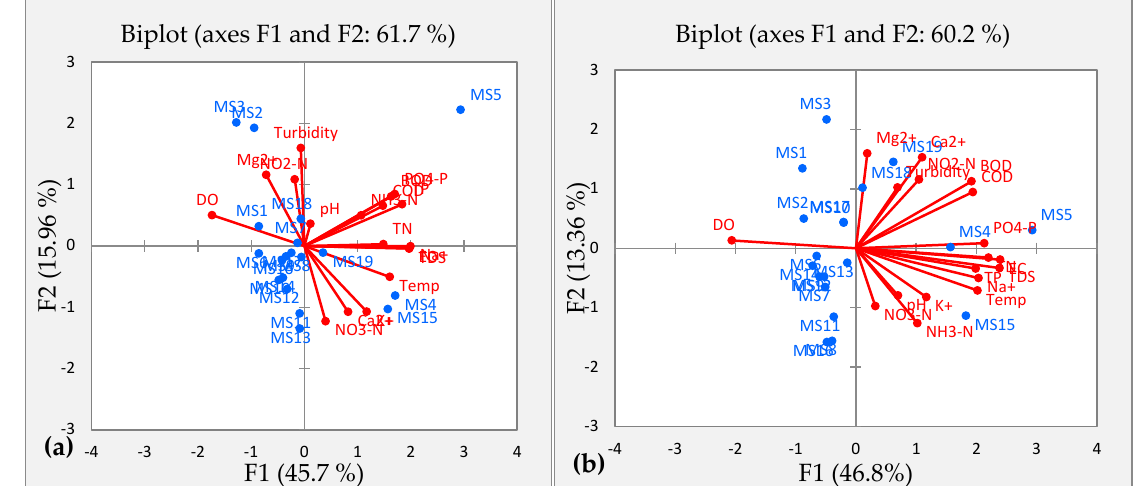
Figure 5. PCA biplots ( a , b ) suggest the projection of the monitoring sites (blue dots) and the variable loadings of the primary components (F1 and F2). The biplots additionally display the relationship between highly correlated variables and monitoring stations for dry ( a ) and wet ( b ) seasons. High and low values indicate strong positive and negative correlation, respectively, while values close to 0 imply weak correlation between F1 and F2 and the respective parameter.